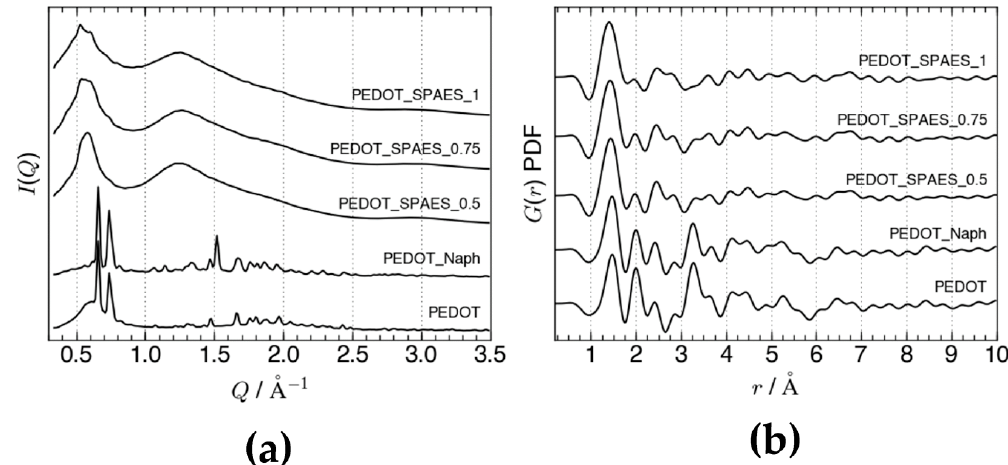
Figure 4. ( a ) Low-angle region of the diffraction patterns of the five samples as a function of momentum transfer (Q). ( b ) Pair distribution function curves of the same samples up to 10 Å; the first peak around r = 1.40 Å contains all the nearest-neighbor bond distances in the polymers. The five datasets are offset for clarity in both panels.